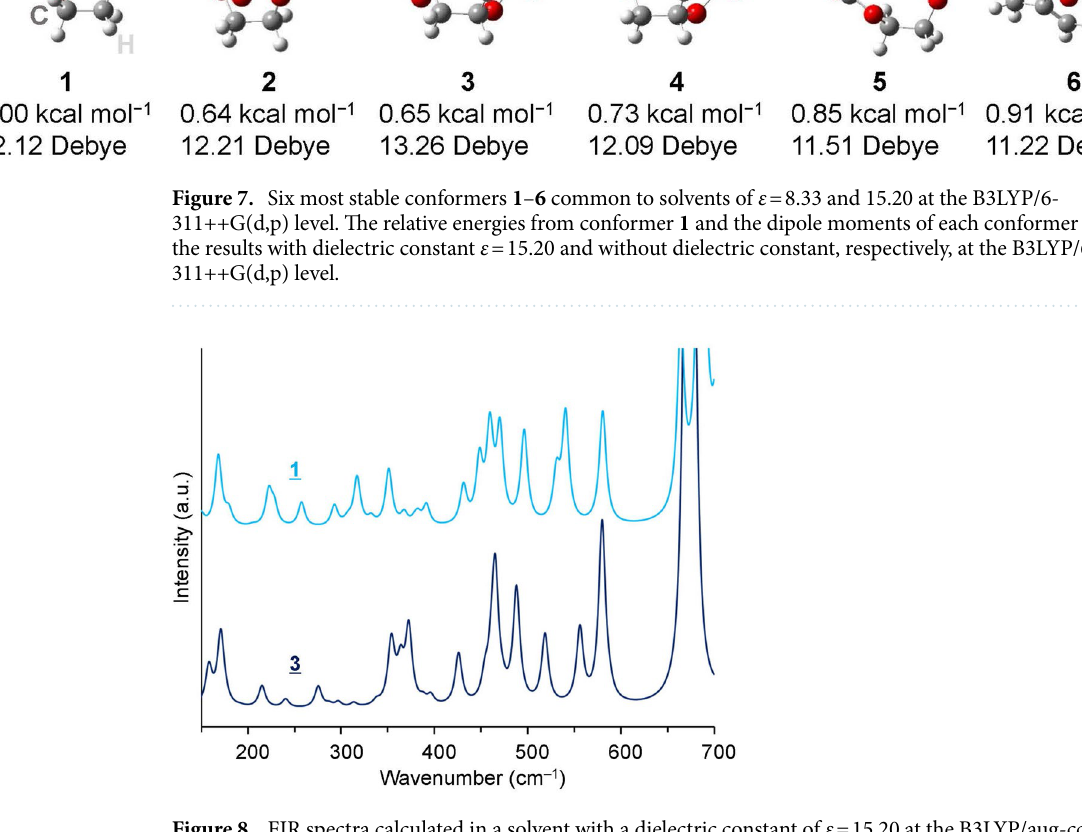
Figure 8. FIR spectra calculated in a solvent with a dielectric constant of ε = 15.20 at the B3LYP/aug-cc- pVTZ level with dispersion correction, for conformers 1 and 3 in Fig. 7. The spectra are vertically offset. The FWHM is set to the same value as that of the well-separated sharp peak at 423 cm −1 observed at 4 K in Fig. 2a (FWHM = 4.4 cm −1